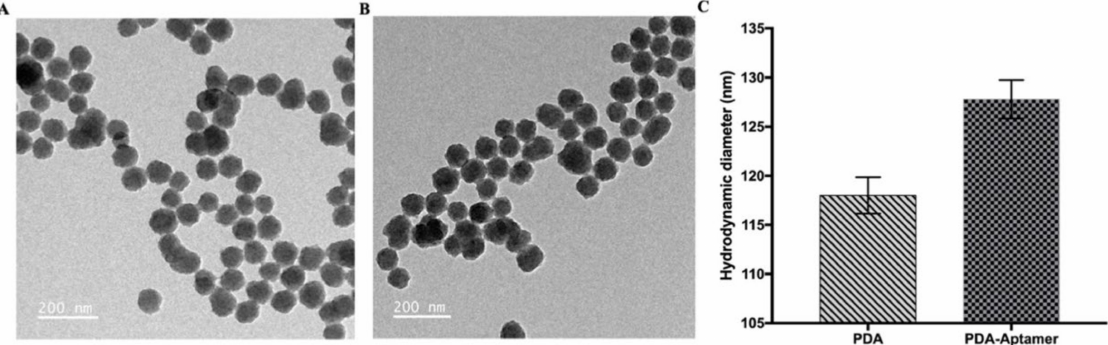
Figure 3. TEM images of ( A ) PDA-NPs and ( B ) PDA-aptamer NPs showing monodispersed spherical distribution. ( C ) DLS measurements of PDA-NPs and PDA-aptamer